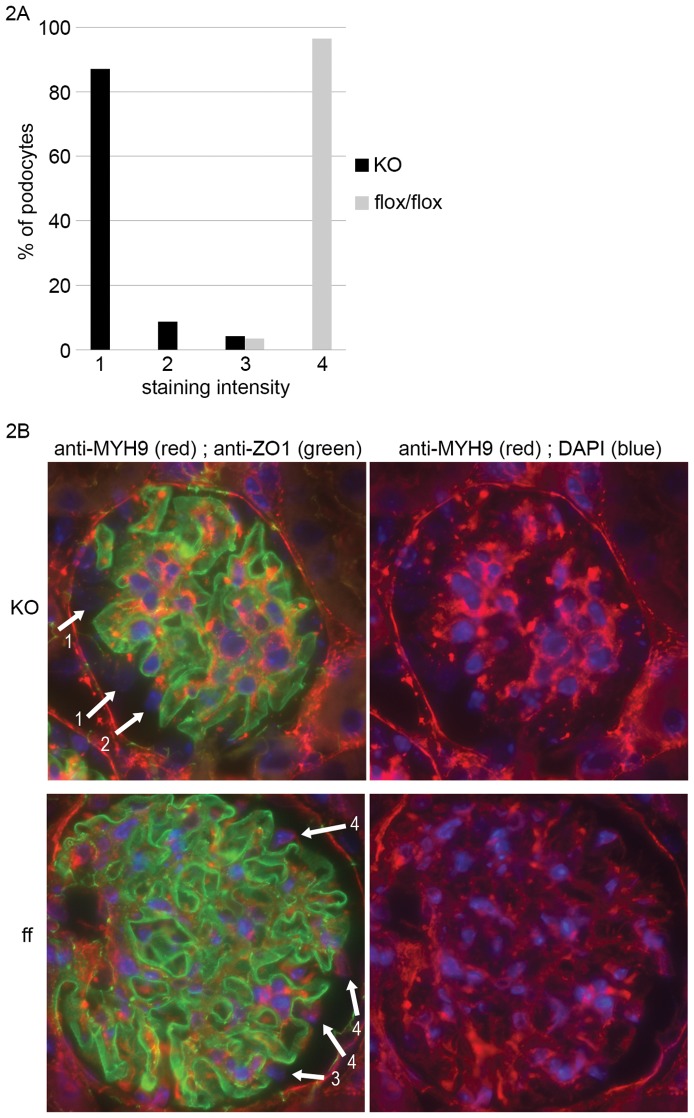
MYH9 podocyte staining verifies deletion in PodΔMyh9
 mice.
MYH9 protein was assessed by immunofluoresence in perfusion-fixed, paraffin-embedded kidneys of adult mice. Within the glomerulus it can be difficult to identify podocytes from mesangial cells or the endothelium, and in the KO mice, Myh9 staining of mesangial cells towards the center of the glomerulus remains quite bright. Definitive podocytes can be assessed by considering cells that are on the outside of green ZO-1 staining and are facing into Bowman's space. Arrows in (B) point to several podocytes, and in the KO the nuclei remain visible with DAPI, but the diffuse red cytoplasmic staining of Myh9 is absent. (A) Tally of podocyte staining from 178 podocytes of 35 glomeruli from 2 KO mice (Podocin::Cre/+; Myh9flox/flox) compared to 114 podocytes of 21 glomeruli from “ff control” littermates (cre−; Myh9flox/flox). Scoring of MYH9 staining intensity was subjective, based on agreement of 2 individuals: (1) = no staining, (2) = faint/equivocal staining, (3) = moderate/incomplete staining, (4) = robust staining. The majority of podocytes from KO mice scored a “1” (no staining) and the majority of podocytes from control ff mice scored a “4” (robust staining). There is a significant difference between the KO and ff control MYH9 staining intensity in podocytes (non parametric Mann-Whitney Rank Sum test, p<0.0001). (B) Examples of stained glomeruli used in scoring from part (A), taken at 630× magnification from KO mice (top) and ff control mice (bottom) with representative podocytes and subjective scores (arrows with numbers 1–4). To minimize differences in processing and staining between genotypes, deparaffinization, blocking, staining and scoring were performed on kidneys of each genotype in parallel. Two primary antibodies were mixed together (rabbit α-MYH9 and mouse α-ZO1) as a “master mix” then aliquoted to all sections (except a secondary-only control). Both secondary antibodies were mixed together (Alexa-Fluor, 1∶1500 goat α-mouse488 and 1∶1500 goat α-rabbit594 then aliquoted to all sections. As seen in Fig. 2B, ZO-1 staining was similar in KO and ff control mouse glomeruli suggesting that the steps of deparafinization through antibody washing were performed consistently on slices handled in parallel, and this was also true for MYH9 staining of tubules and of mesangial cells. Occassional podocytes from control mice showed reduced staining, “3,” which we speculate could arise from podocytes that were obliquely cut such that only a small portion of cytoplasm was included on the slice. As previously reported we speculate that the few punctae of staining in our KO mice may represent inclusion bodies [3], but diffuse cytoplasmic staining as seen in control mice was never observed in KO mouse podocytes. The absence of robust staining (“4”) and the minimal moderate/equivocal staining (“3”) from 178 KO mouse podocytes suggests that mosaicism with incomplete gene excision occurred at a very low level in our KO mice. While we have not observed a difference in staining intensity between the Myh9flox/flox allele and the Myh9 wild type allele, floxed alleles can theoretically reduce expression, which prompted us to choose the Myh9flox
/flox mice rather than wild type mice as controls for staining in parallel with the KO mice.